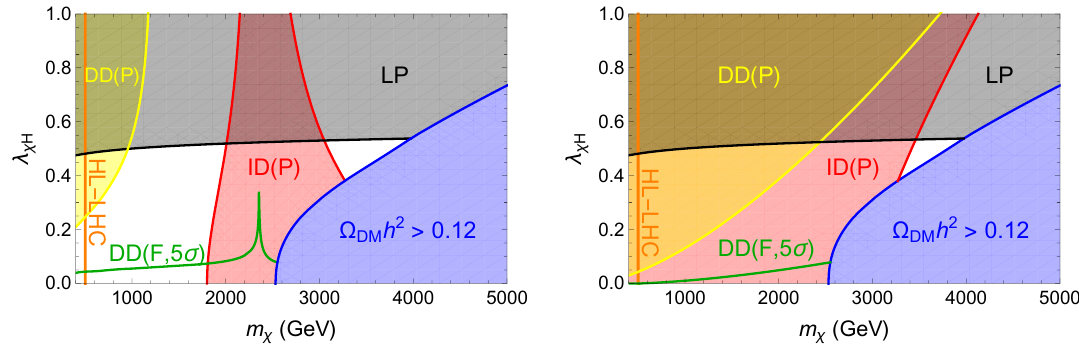
Figure 7 . The scalar triplet dark matter can be detected at 5 σ level in the region above the dark green line by XENONnT. All shaded regions and the orange line are the same as those in figure